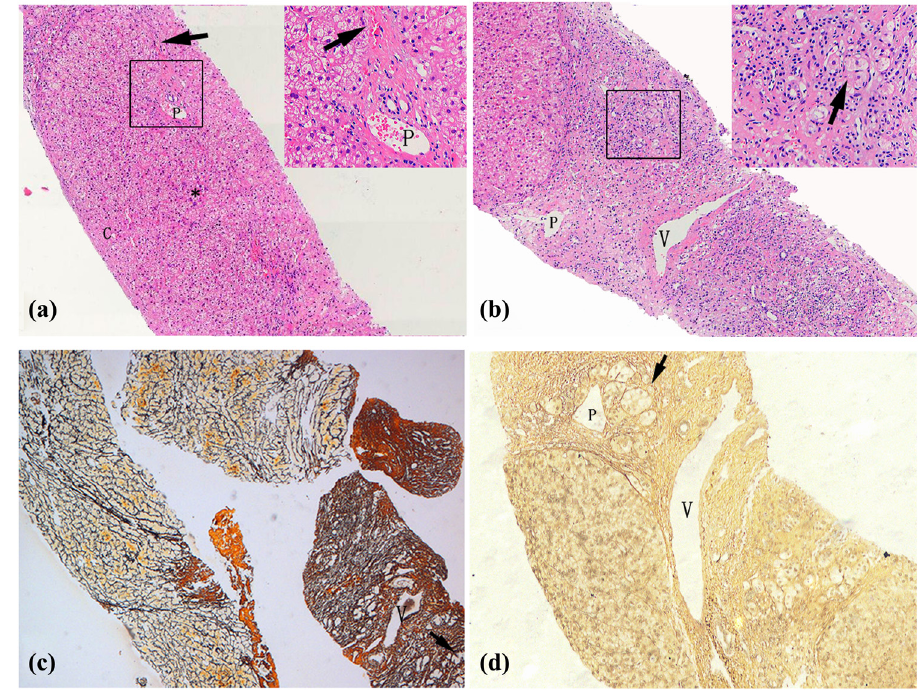
Figure 2: Pathological characteristics of liver tissue in patients. ( a ) Liver cells with di ff use oedema, balloon - like degeneration, dotted/focal necrosis ( * ) , and local bridging necrosis ( arrow ) in Case 2 ( HE 40 × and HE 200 ×) . ( b ) Hepatic lobules were replaced by proliferative fi brous tissues with hepatocyte regeneration ( arrow ) in Case 2 ( HE 40 × and HE 200 ×) . Uneven fi brosis of liver tissues and clusters of regenerative cells ( arrow ) surrounded by reticulum fi bres in Case 1 ( c, Reticulum 20 ×) and Case 2 ( d, Reticulum 40 ×) . C: central veins, V: hepatic vein, P: portal